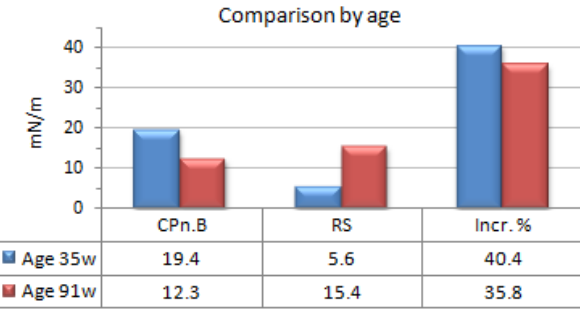
Figure 7. Typical example of age on recovery of functional